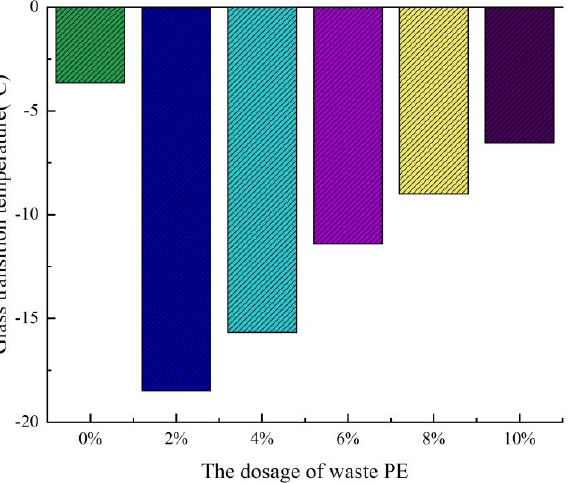
Figure 5. Glass transition temperatures of waste plastic/rubber-modified asphalt at various dosages of waste polyethylene.